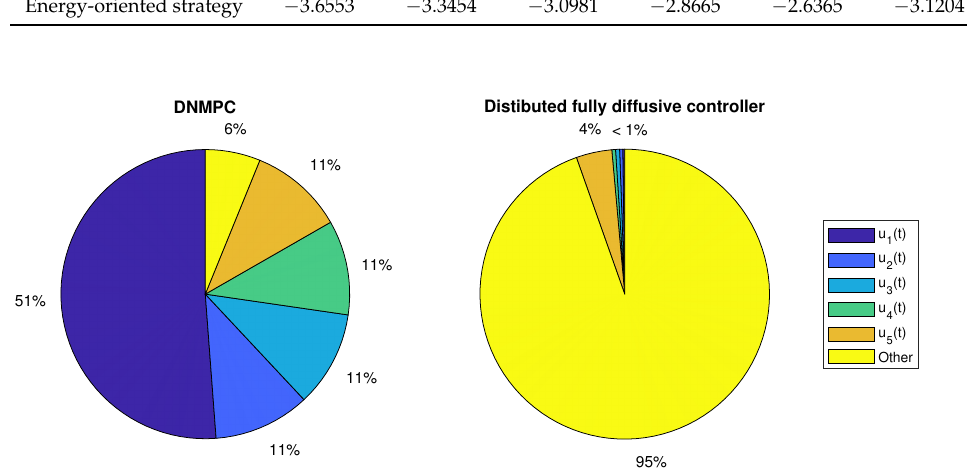
Figure 5. Computational load in energy-oriented scenario and basic-scenario with controller